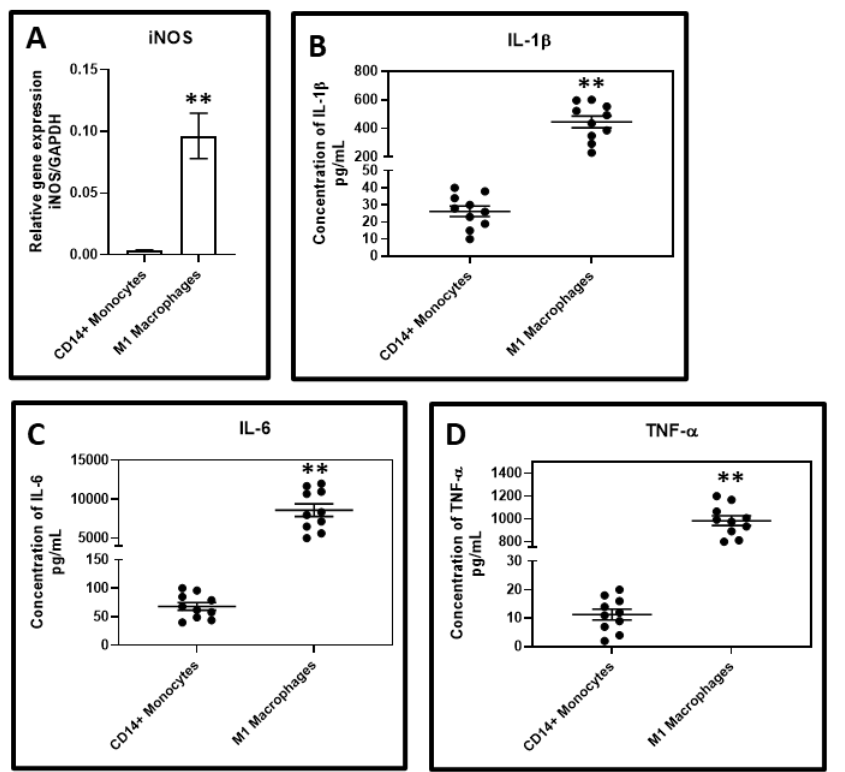
Figure 4. ( A )—Comparative gene expression analysis between GCF differentiated macrophages and untreated CD14+ monocytes for iNOS gene expression (** p < 0.0001). Comparative secretome analysis between GCF differentiated macrophages and untreated CD14 monocytes for ( B )—IL-1 β (** p < 0.0001), ( C )—IL-6 (** p < 0.0001), ( D )—TNF- α (** p < 0.0001) respectively.